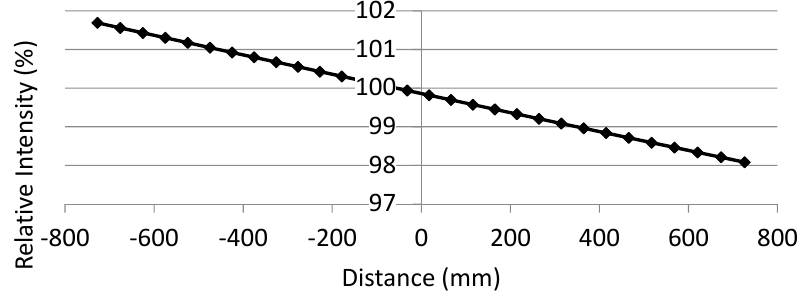
Figure 7. Relative intensity of the illumination profile as a function of distance (mm) from the centerline of the camera.